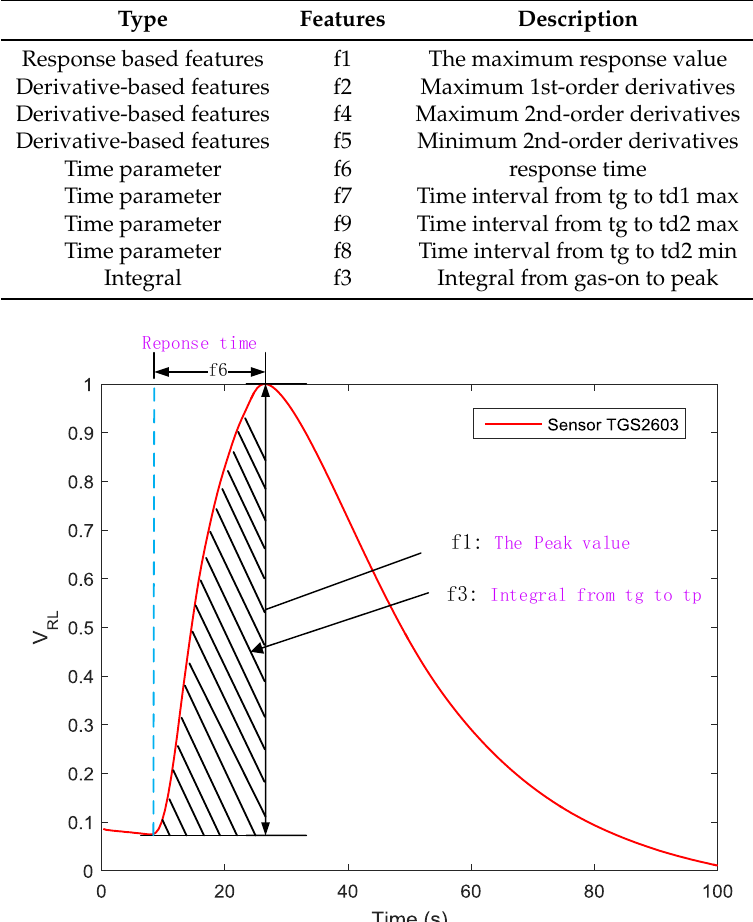
Figure 3. Feature 1, 3, and 6 extracted from each sensor response curve.